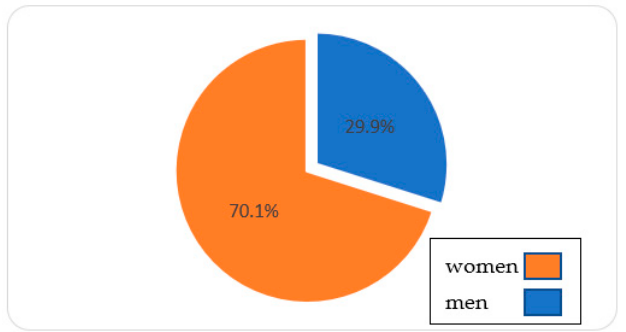
Figure 1. Sociodemographic: Sex.